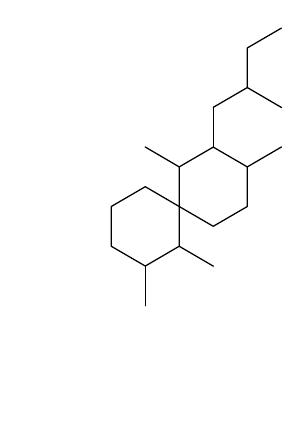
Figure 2. Salvileucalane